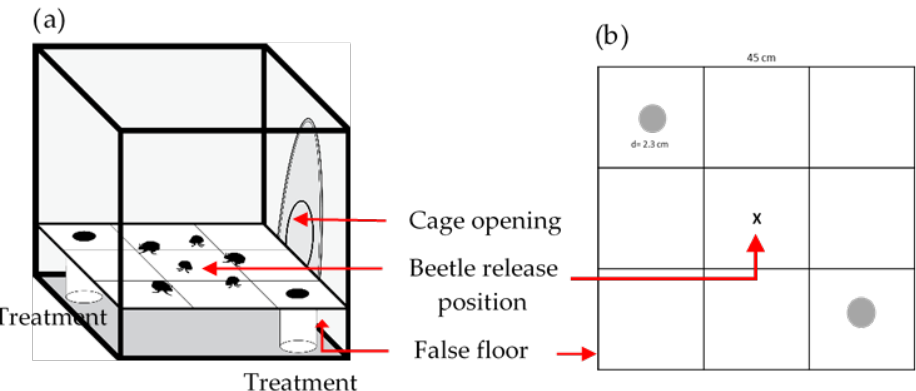
Figure 11. ( a ) Diagram of the cage olfactometer. Beetles were released at the central ‘X’. ( b ) False floor that provided a uniform surface for the beetles to walk upon and prevented contact with dung and chemical lures.